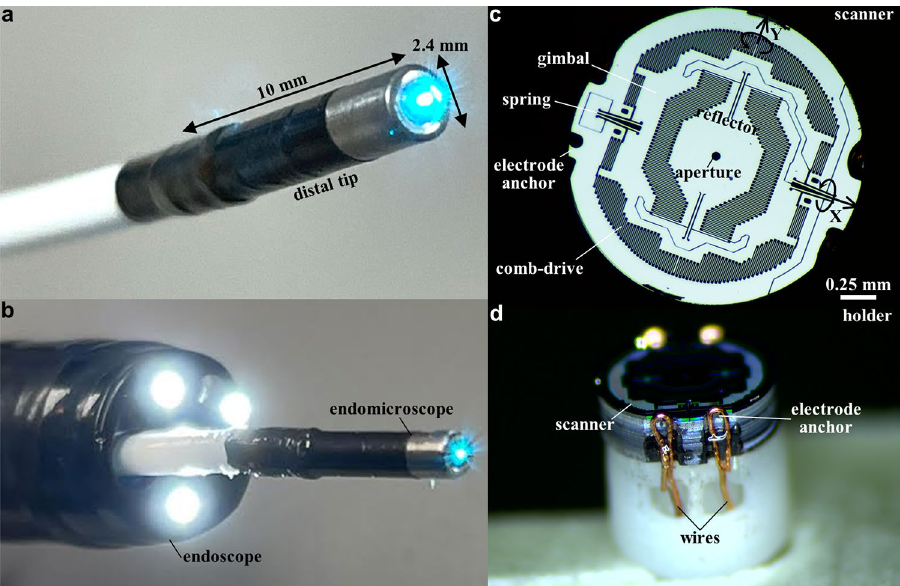
Figure 1. Confocal laser endomicroscope (CLE) and MEMS scanner. Photo is shown of ( a ) the packaged instrument with rigid distal tip dimensions of 2.4 mm in diameter and 10 mm in length, and ( b ) forward passage through the working channel of a standard medical endoscope (Olympus CF-HQ190L). ( c ) Front view of the scanner shows a reflector with a 50 μm diameter central aperture to allow excitation beam to pass.